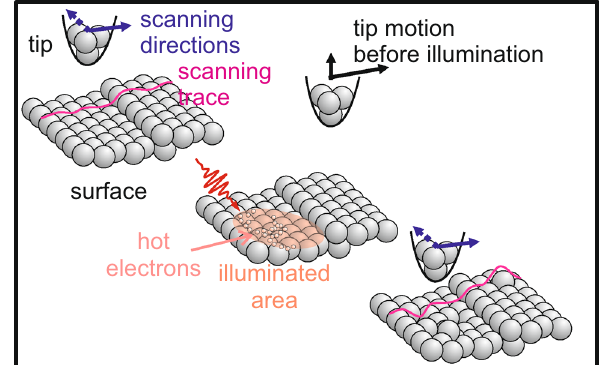
Figure 1. Schematics of the